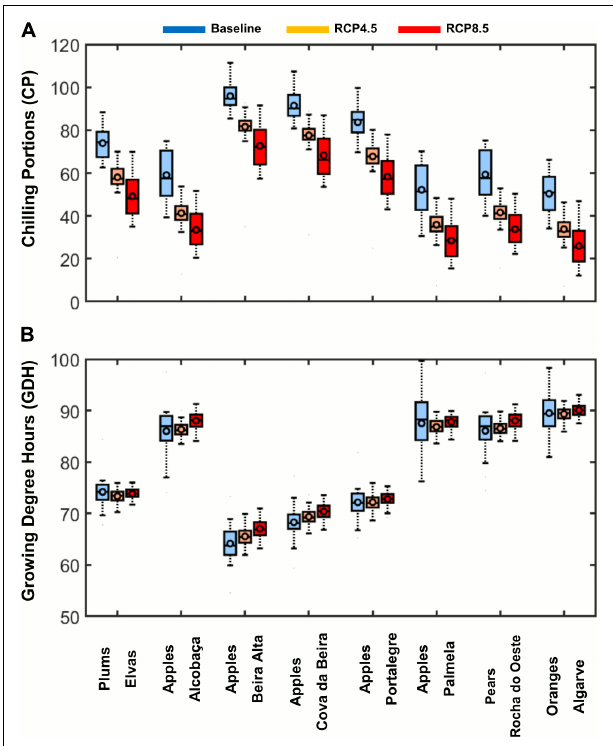
FIGURE 6 | Boxplots of the distribution of (A) Chilling Portions (CP) and (B) Growing Degree Hours (GDH), for baseline and two future scenarios (RCP4.5 and RCP8.5), and by the denomination of origin regions. Each box represents the 25th and 75th quantiles, the inner circle the mean, and the inner line the median. The outer whiskers represent the maxima and minima. GDH values are shown in × 10 3